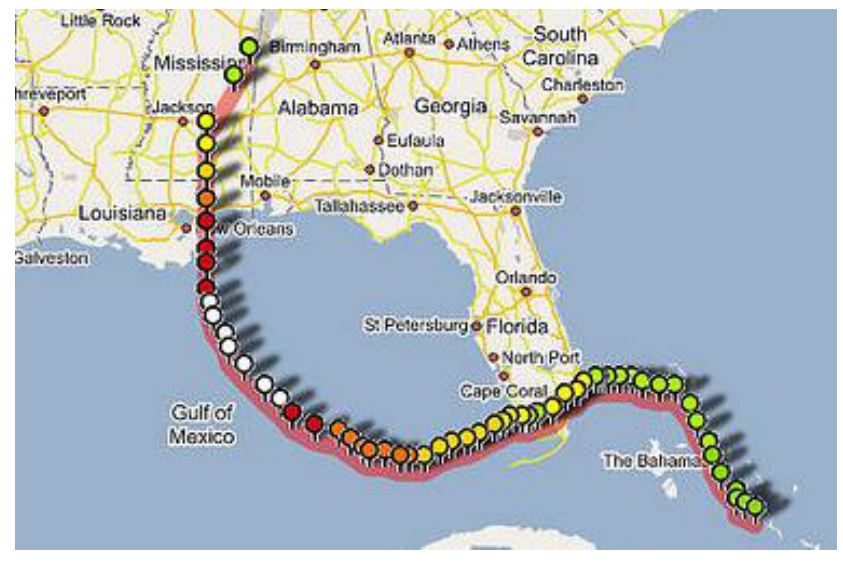
1 . Hurricane Katrina Track—Google Map. (http://www.flickr.com/photos/